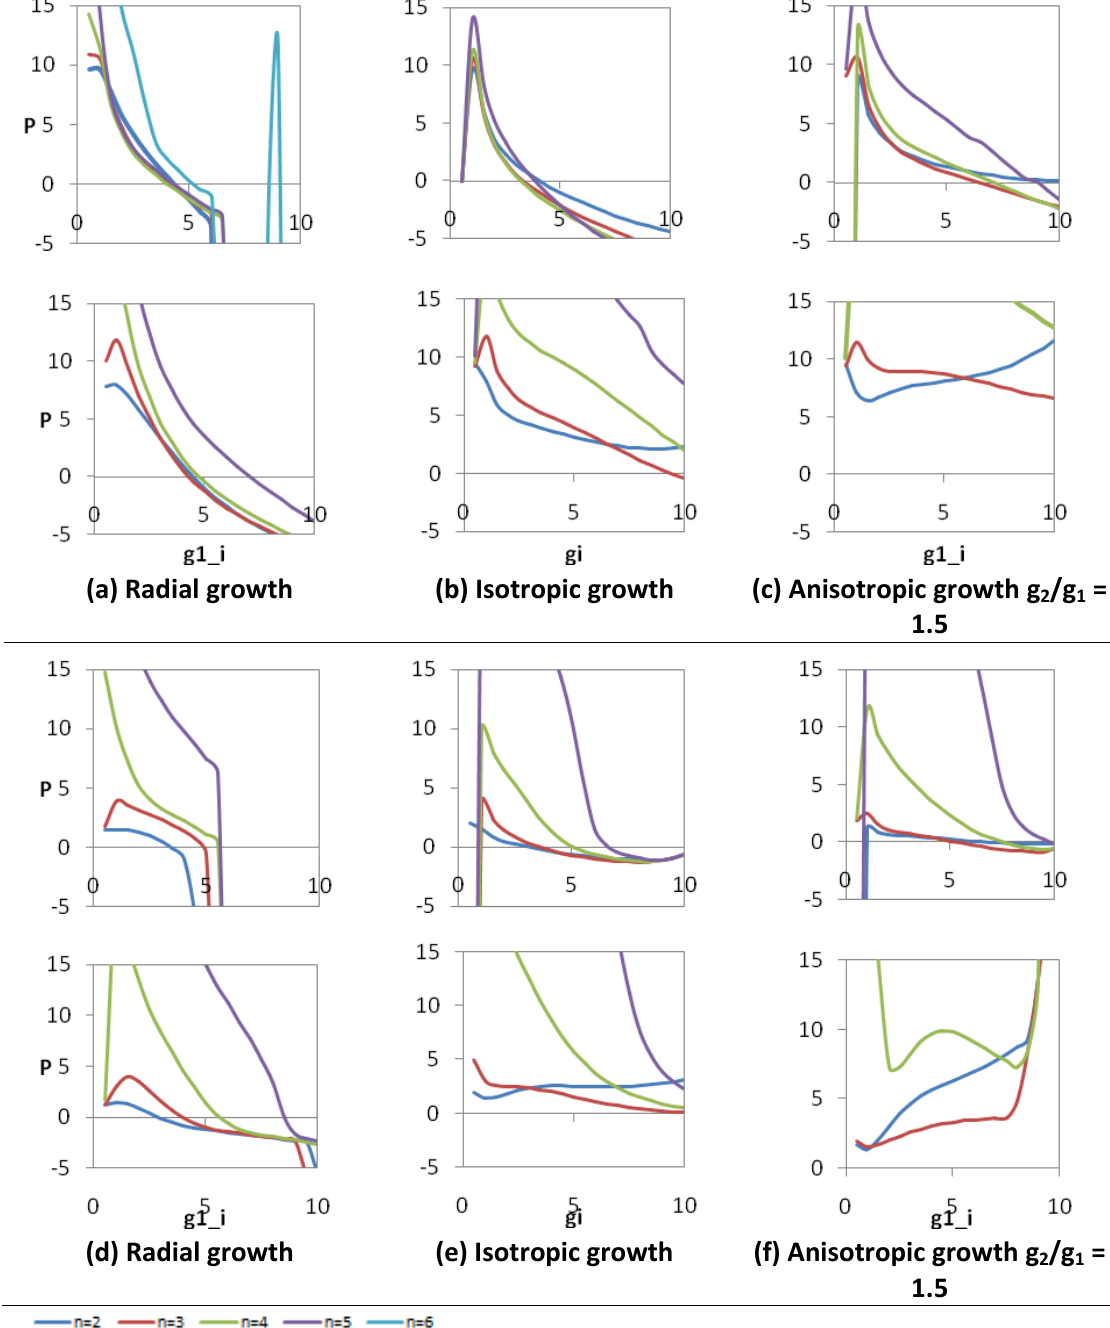
Figure 14: Effect of stiffness ratio and fiber density. (a-c) Larger stiffness ratio. µ 0 / µ i = 5 , k 1 = 1 , k 2 = 0.2 . Enforced circular outer boundary simulating loose skin. First row: 𝛾 = PI/6; second row: 𝛾 =PI/3. (d-f) Larger fiber density. µ 0 / µ i = 1 , k 1 = 3 , k 2 = 0.2 . Enforced circular outer boundary simulating loose skin. First row: 𝛾 = PI/6; second row: 𝛾 =PI/3.